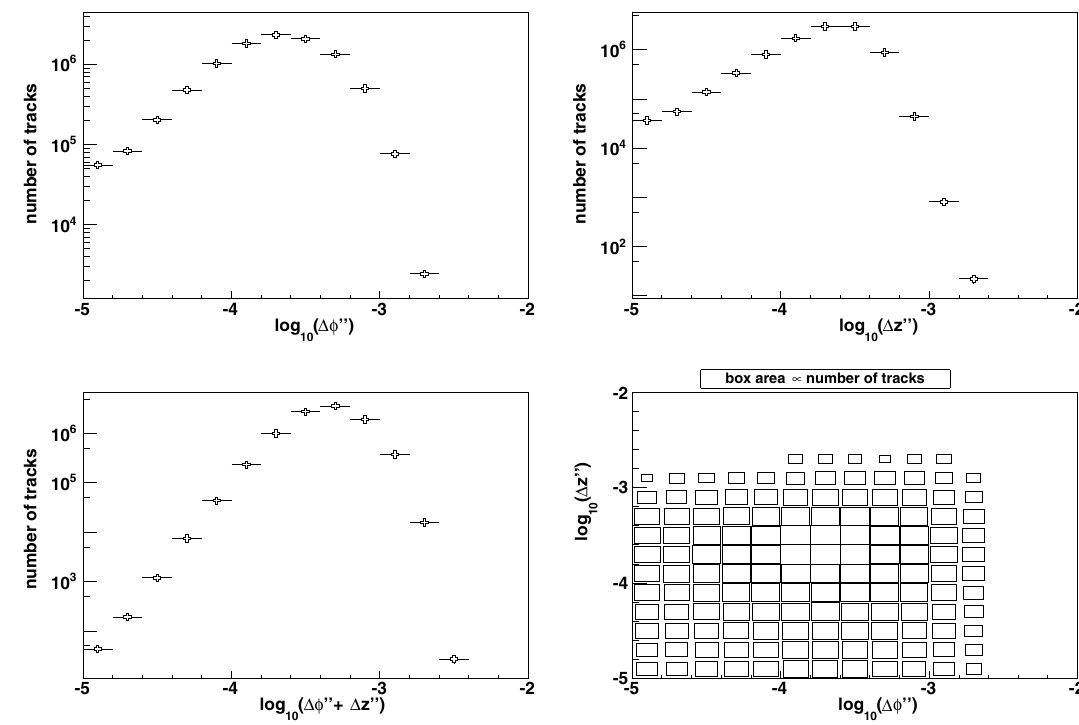
Figure 8. Distributions of reconstructed track quality metrics for signal tracks; (top left) smoothness metric �φ ′′ in the azimuthal projection, (top right) smoothness metric (cid:31) z ′′ in the longitudinal projection, (bottom left) � z ′′ , and (bottom right) distribution of (cid:31) z ′′ versus �φ ′′ . overall smoothness metric �φ ′′ +